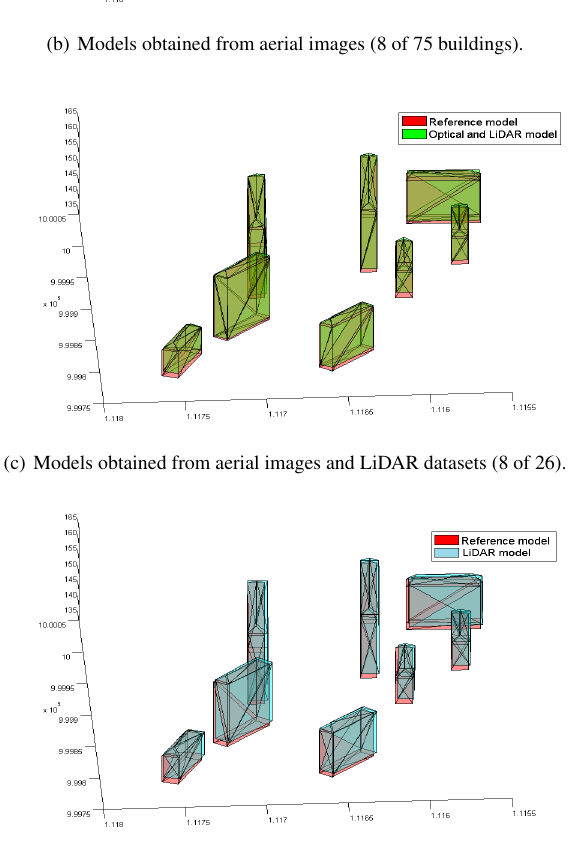
Figure 7: Reference and tested building models.